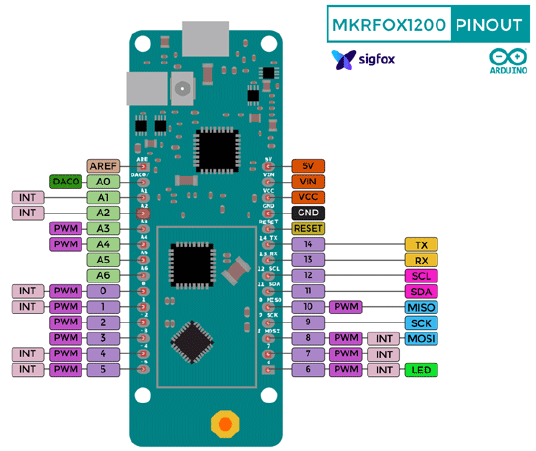
Figure 3. Arduino MKR FOX 1200 pinout scheme.